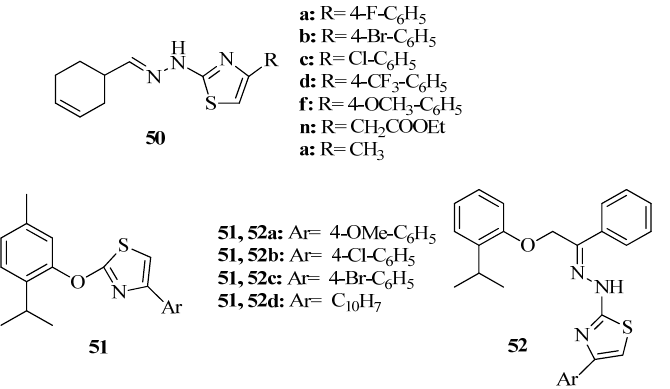
Figure 18. Structures of thiazoles containing cyclohexene moiety and 4-phenyl-1,3-thiazole and 2-hydrazinyl-4-phenyl-1,3-thiazole derivatives.